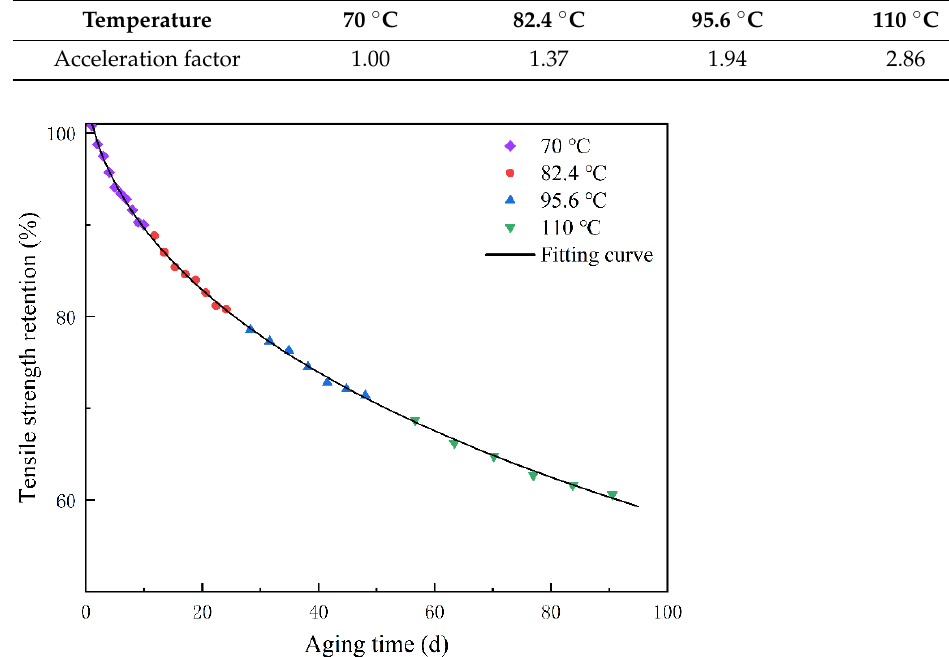
Table 2. Identification results of rubber aging acceleration factors at different temperatures.